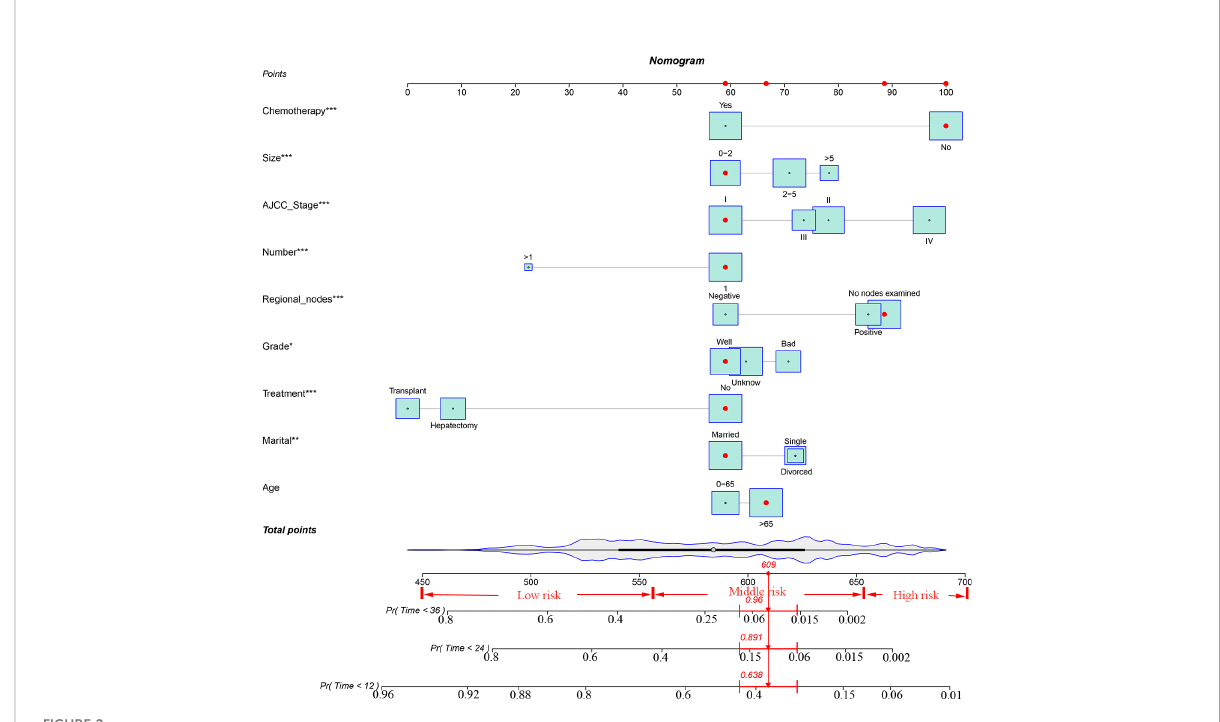
FIGURE 2 A nomogram for ECCA patients and new risk strati fi cation.